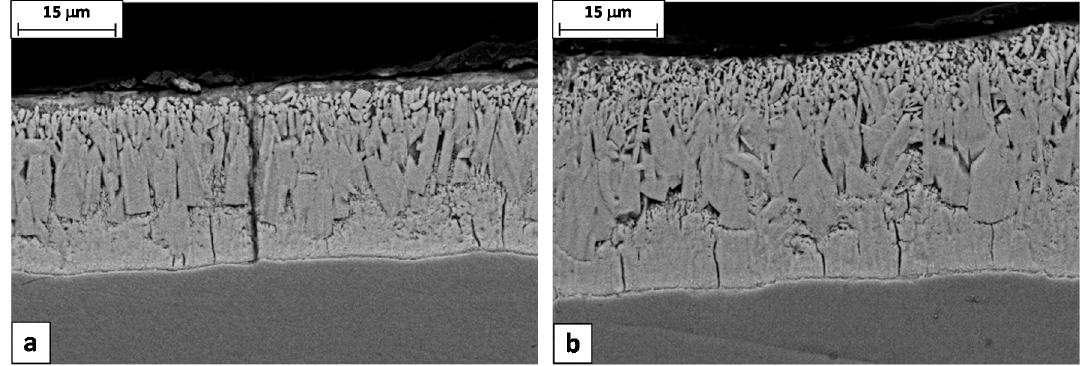
Figure 11. SEM images of longitudinal sections of ( a ) steel 9A and ( b ) steel 9B samples.